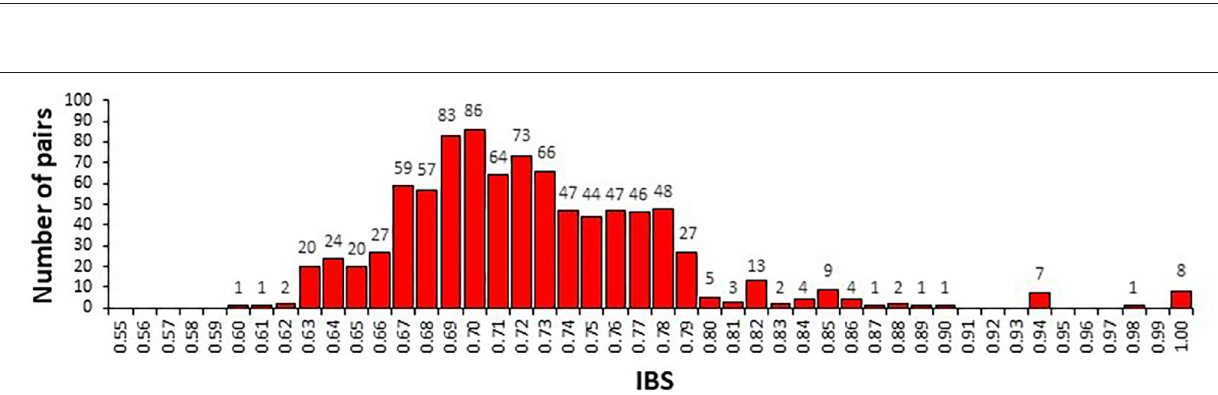
Frontiers in Plant Science | www.frontiersin.org